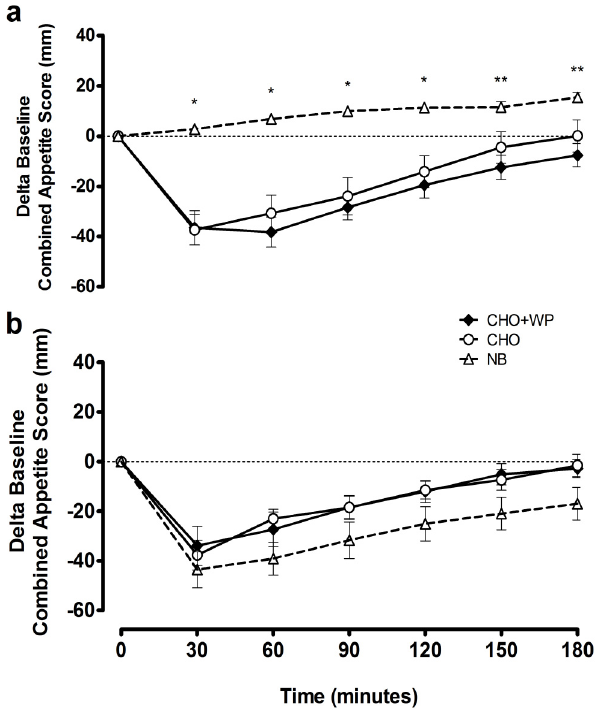
Figure 4. Mean ± SEM delta baseline changes in combined appetite score during the post ‐ breakfast ( a ) and post-lunch ( b ) periods. Significant differences ( p < 0.05) between trials at individual time points are defined as follows; * NB vs. CHO + WP and CHO, ** NB vs. CHO + WP. CHO: high-carbohydrate breakfast trial; CHO + WP: high-carbohydrate breakfast with added whey protein trial; NB: no breakfast trial. Table 3. Time-averaged areas under the curve for subjective appetite variables during post-breakfast and post ‐ lunch postprandial periods. CHO + WP 1,2 CHO NB Combined appetite score (mm)